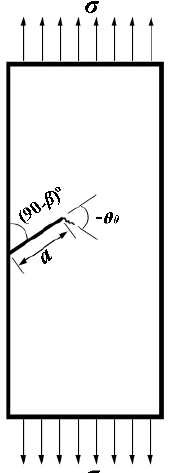
Figure 14: Strip with a straight crack under mixed mode